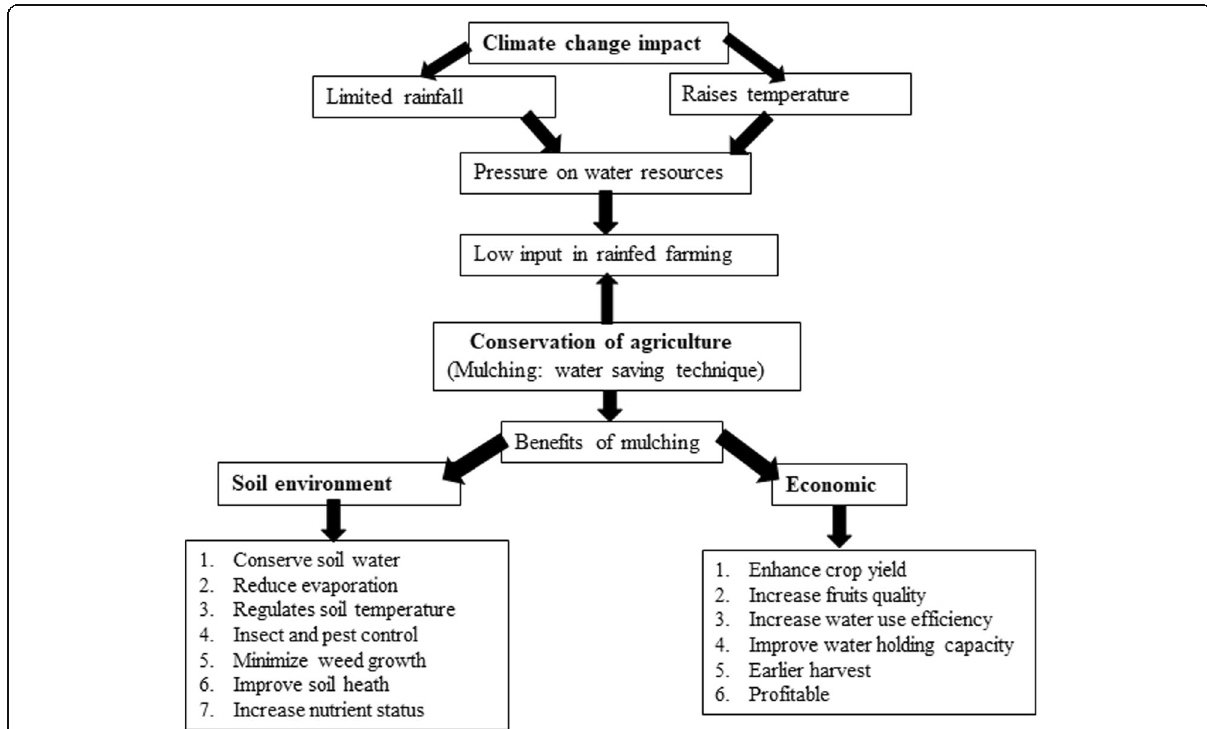
Fig. 1 Schematic diagram of the conservation agriculture interacts with climate and